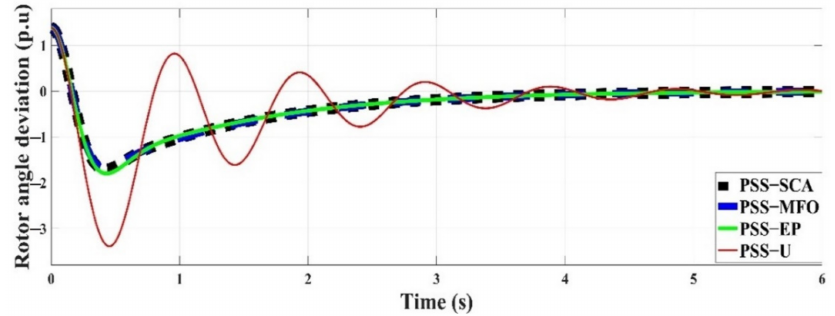
Figure 13. Rotor angle deviation for loading condition 4 of the SMIB with PSS.